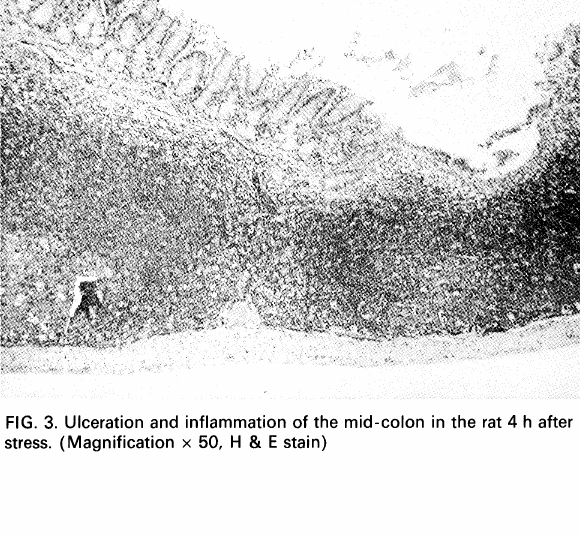
FIG. 3. Ulceration and inflammation of the mid-colon in the rat 4 h after stress. (Magnification x 50, H & E